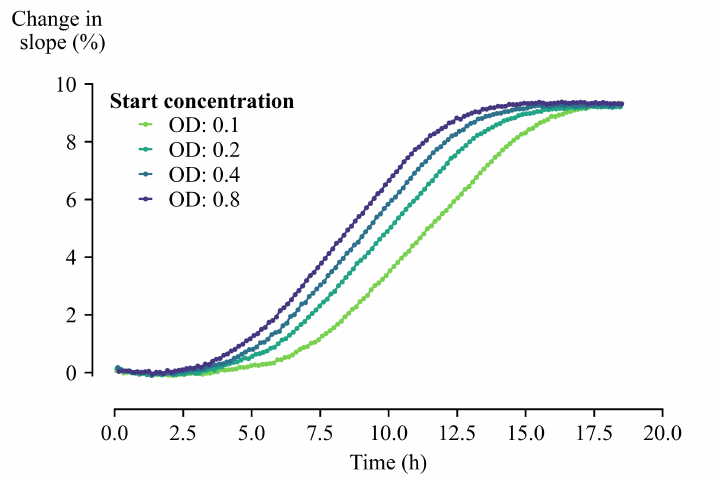
Figure 6. The percentage change in slope of proliferating Saccharomyces cerevisiae in YP medium with varying starting concentration. It can clearly be seen that these slopes are influenced by the amount of cells present at the beginning of the